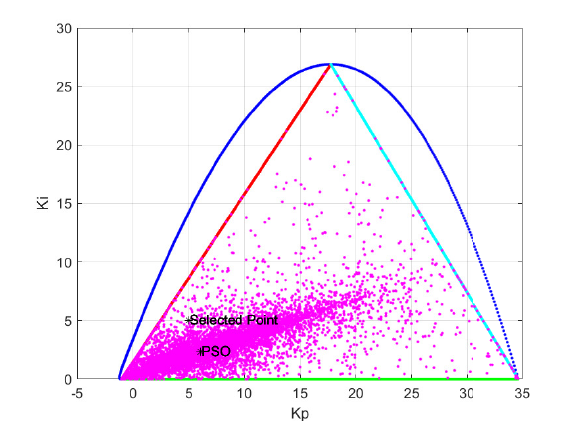
Figure 7. Stability Region and convex stability region of Example 1 Step responses of Example 1 are shown in Fig- ure 8. As seen in Figure 8, the PSO algorithm provides a very good result.